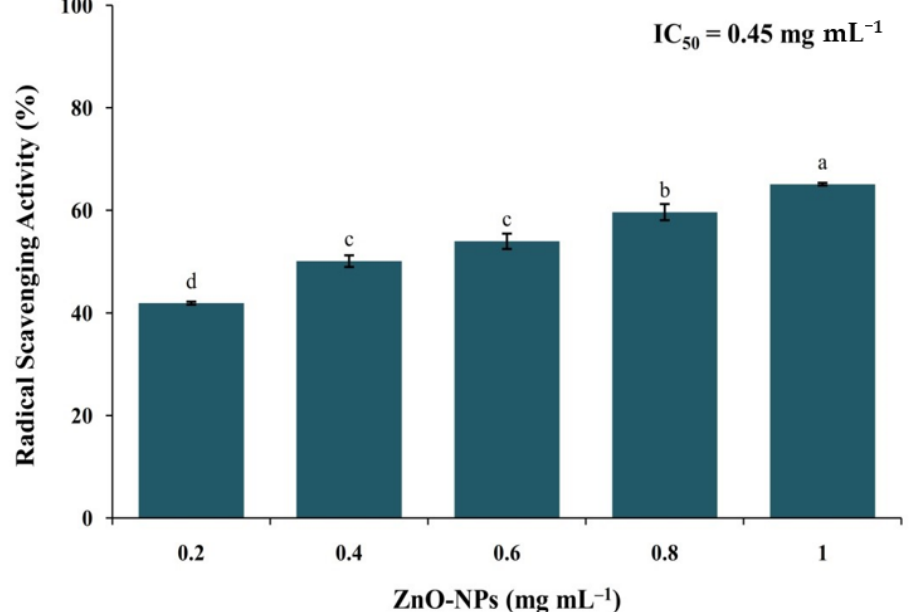
Figure 6. DPPH radical scavenging activity of phyto-fabricated ZnO-NPs from I. obscura aqueous leaf extract. Each value is the mean for three replicates (n = 3), and bars sharing the same letters are not significantly different ( p ≤ 0.05) according to Tukey’s Honestly Significant Difference (HSD). The vertical bar indicates the standard error.